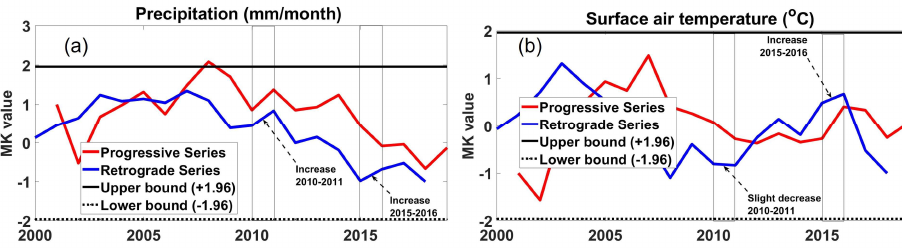
Figure 2. Trends in southern Africa for ( a ) precipitation and ( b ) surface air temperature derived from sequential Mann–Kendal test statistics. Table 2. Intersection points by sequential Mann–Kendall test for southern Africa (values significant at p ≤ 0.05).